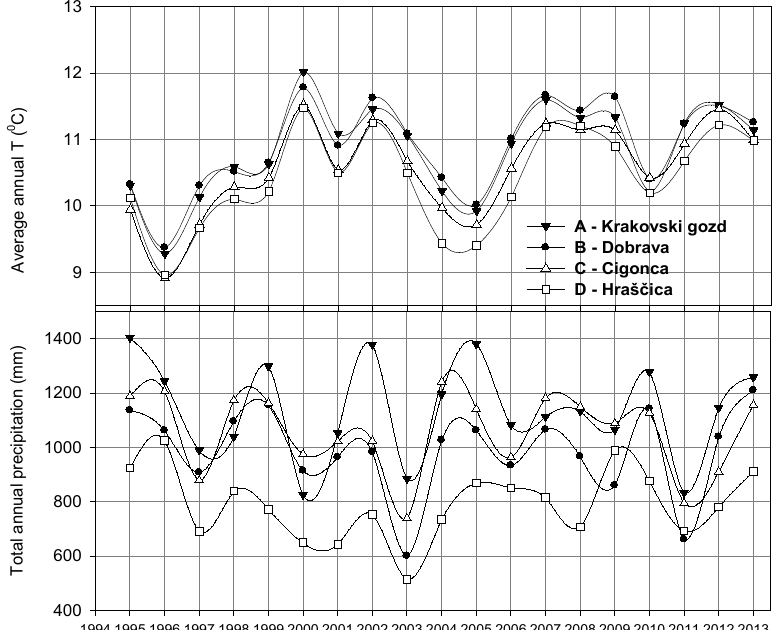
Figure 3. Average annual air temperature and total annual precipitation on research plots